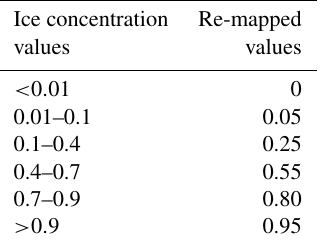
Table 4. Ice concentration values and their categorization used for the ice charts and Barents-2.5km model